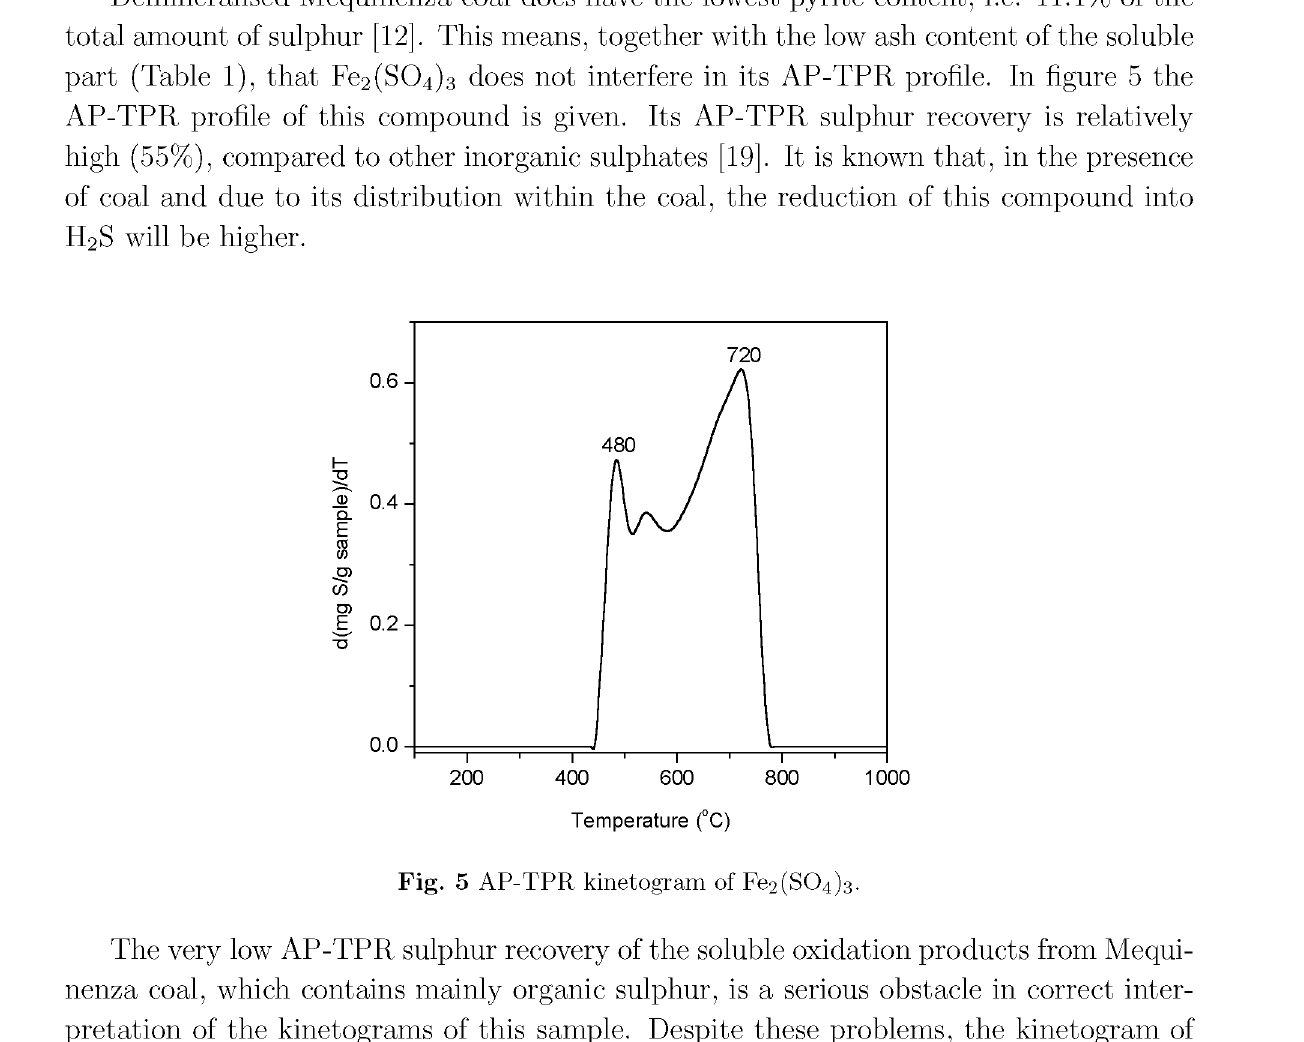
Fig. 3 AP-TPR kinetograms of the solu- ble products of demineralised coals oxidation with HNO3.